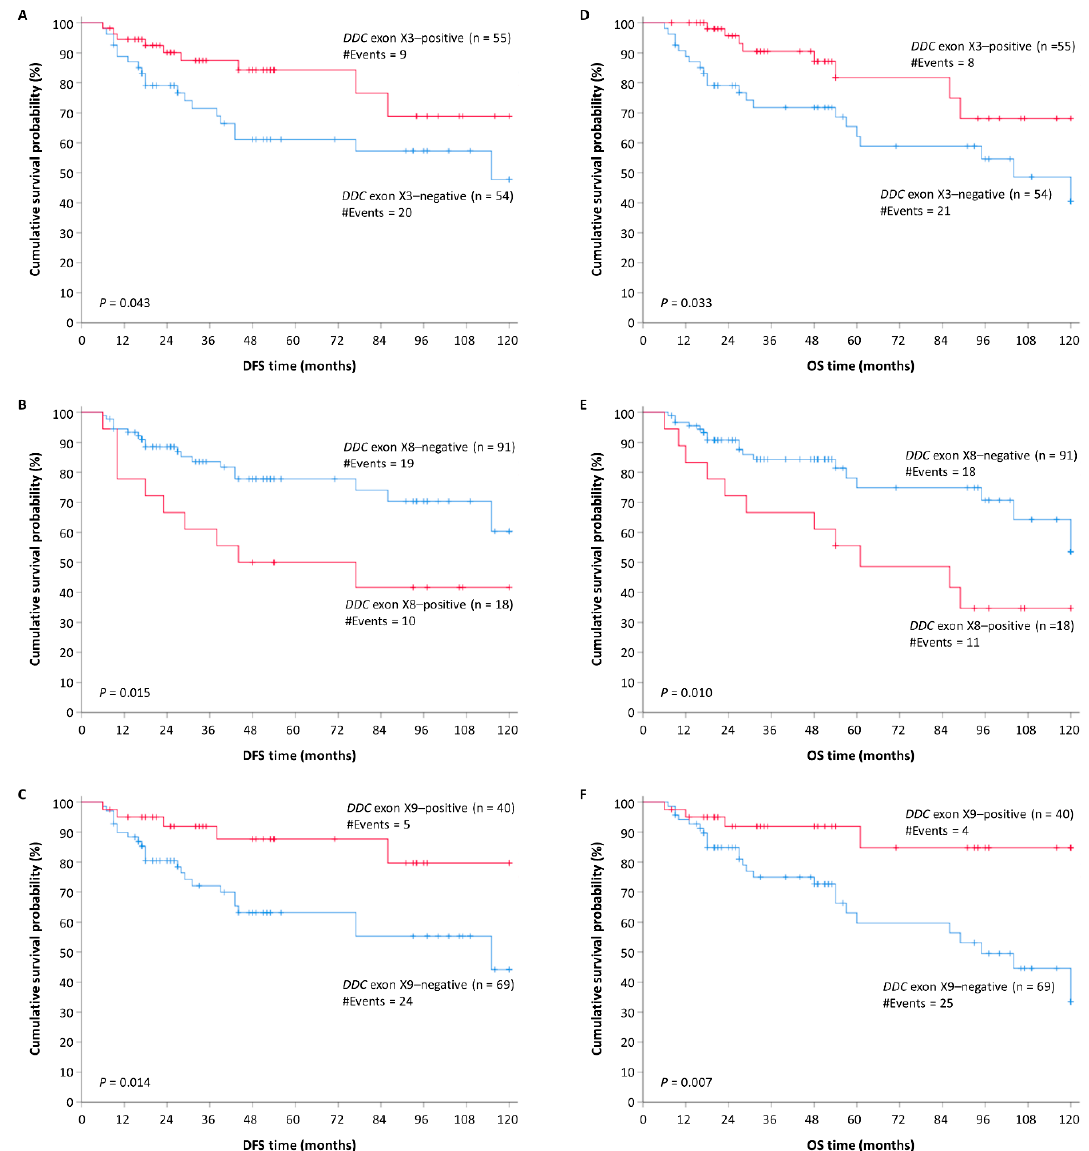
Figure 5. Kaplan–Meier survival curves for the disease-free survival (DFS) and overall survival (OS) times of CRC patients. ( A ) Positive DDC exon X3 expression status is a potential favorable prognostic biomarker of DFS in CRC ( p = 0.043). ( B ) DDC X8-positive patients have a shorter DFS time period than the negative ones ( p = 0.015). ( C ) Positive DDC exon X9 expression status leads to longer CRC patient DFS time ( p = 0.014). ( D ) Patients with DDC exon X3-positive tumors have longer OS period than those with DDC exon X3-negative tumors ( p = 0.033). ( E ) Positive DDC exon X8 expression status is a potential unfavorable prognostic biomarker of OS in CRC ( p = 0.010). ( F ) DDC exon X9-positive patients are characterized by a longer OS time period than the negative ones ( p = 0.007). Table 3. Expression status of DDC novel exons and DFS of CRC patients. Univariate Analysis ( n = 109) Multivariate Analysis 1 ( n = 109)